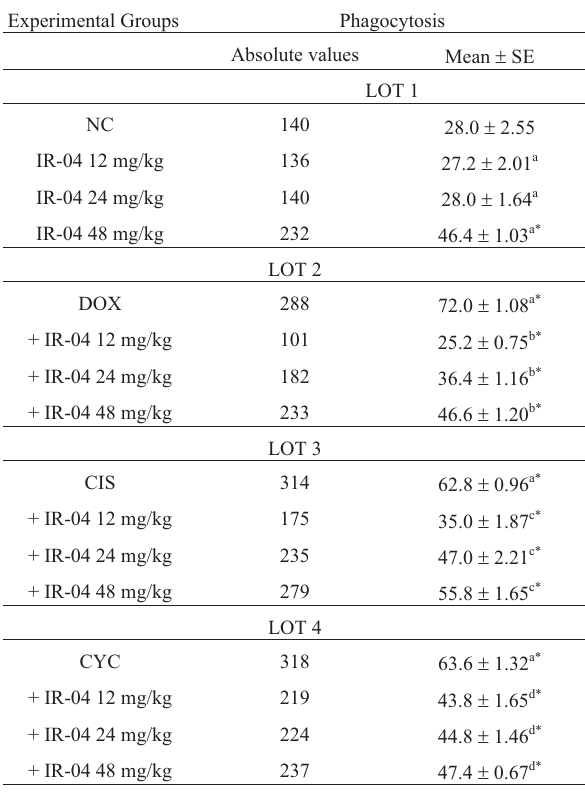
Table 4 - Results related to splenic phagocytosis evaluation. Experimental